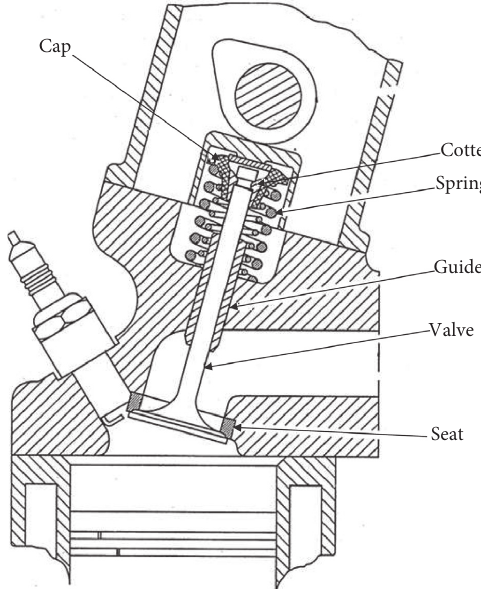
Figure 1: A section of an IC engine showing a poppet valve as- sembly (Source: